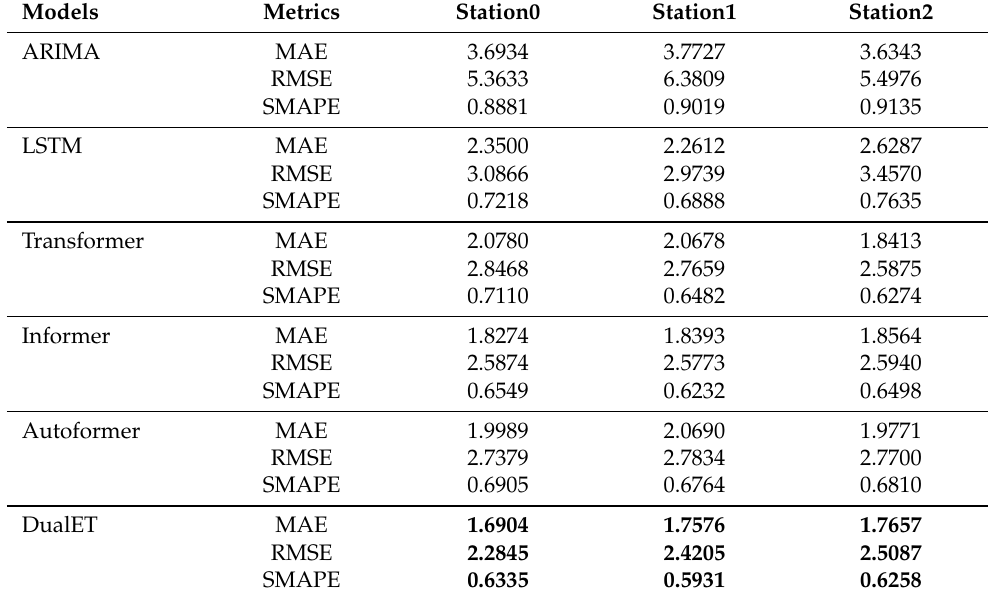
Table 1. Prediction performance of the proposed